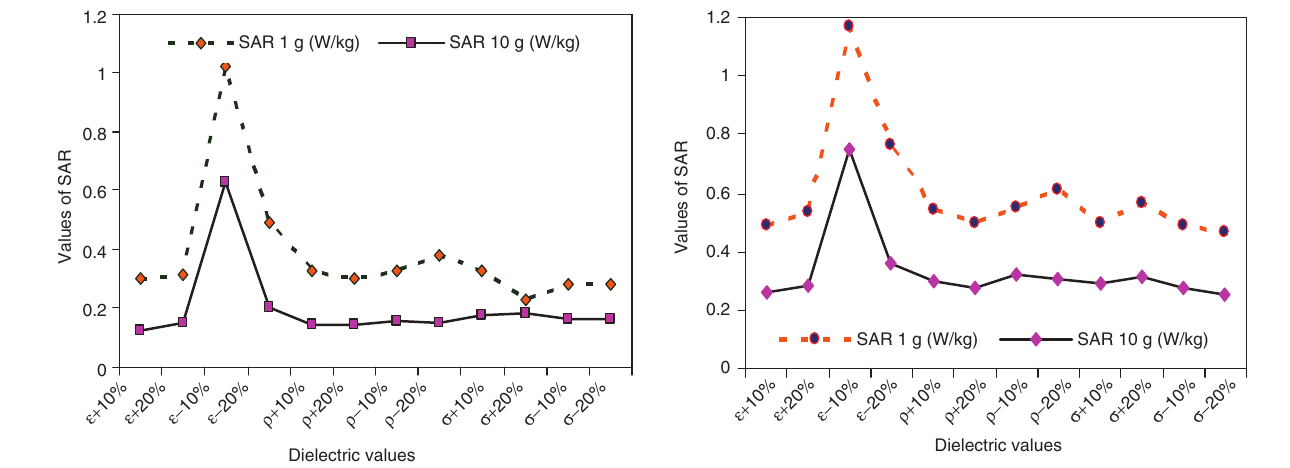
Figure 5 Deviation of the peak of unaveraged SAR in different dielec- tric properties of Rogers R04003 (loss free) substrate at 2450